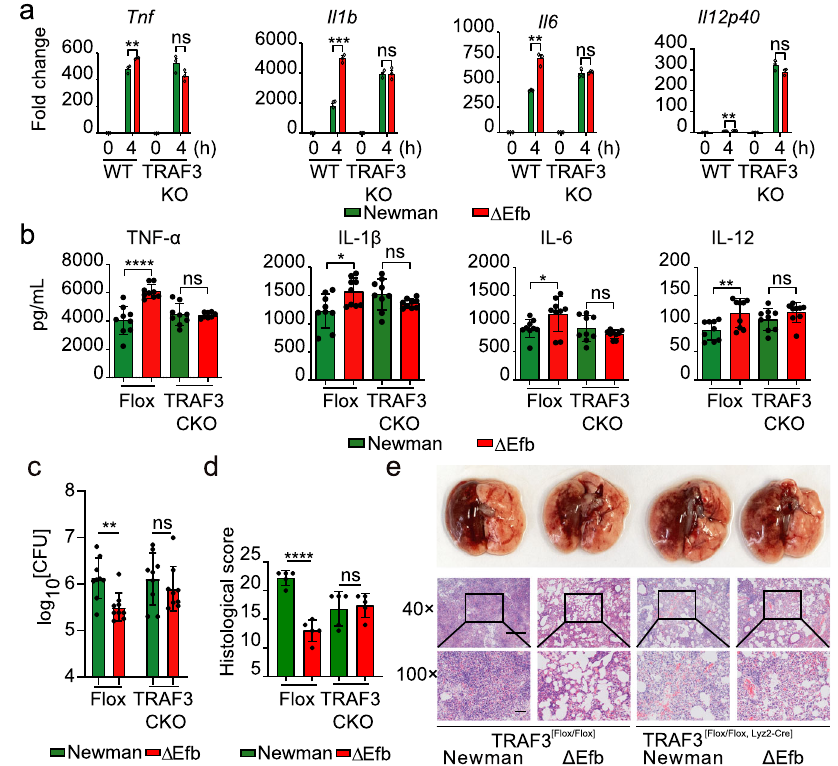
Fig.3|Efbinhibitshostpro-in fl ammatoryresponsesviaTRAF3.a qPCRanalysis of Tnf , Il1b , Il6 , and Il12p40 mRNA of PMs infected with Newman, Δ Efb (MOI=25) for4h;wild-typePMs(WT)wereisolatedfromTRAF3 [ fl ox/ fl ox]